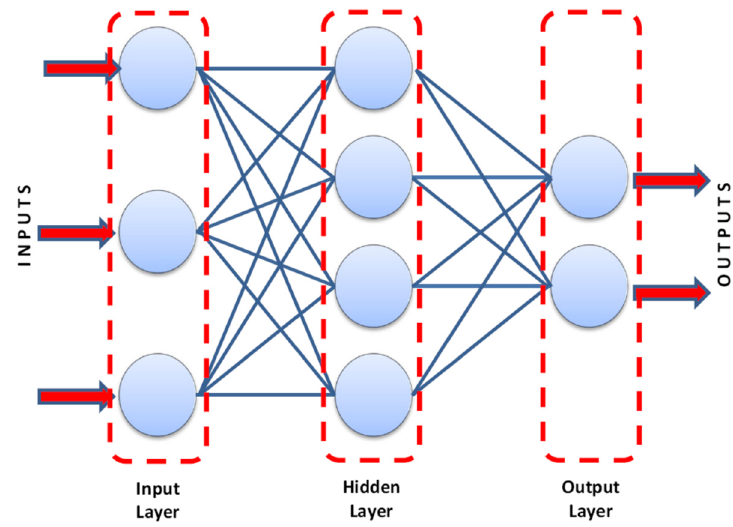
Figure 5. General schematic for the artificial neural network.